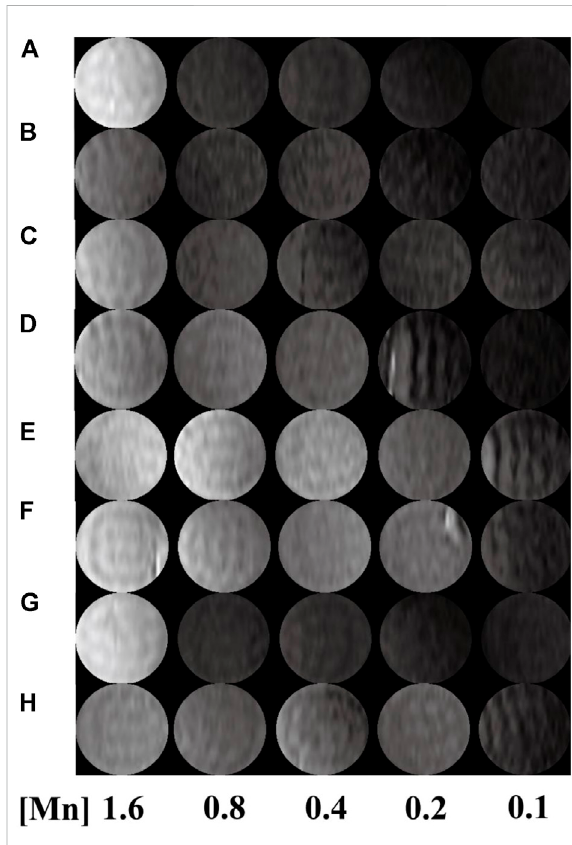
FIGURE 5 T 1 -weighted images G5.NH 2 -DOTA 5 (Gd), G5.NH 2 - DOTA 10 (Gd), G5.NH 2 -DOTA 20 (Gd), and G5.NH 2 -DOTA 30 (Gd) (A, C,E,G) beforeand (B,D,F,H) afteracetylationasfunctionsofGd 3+